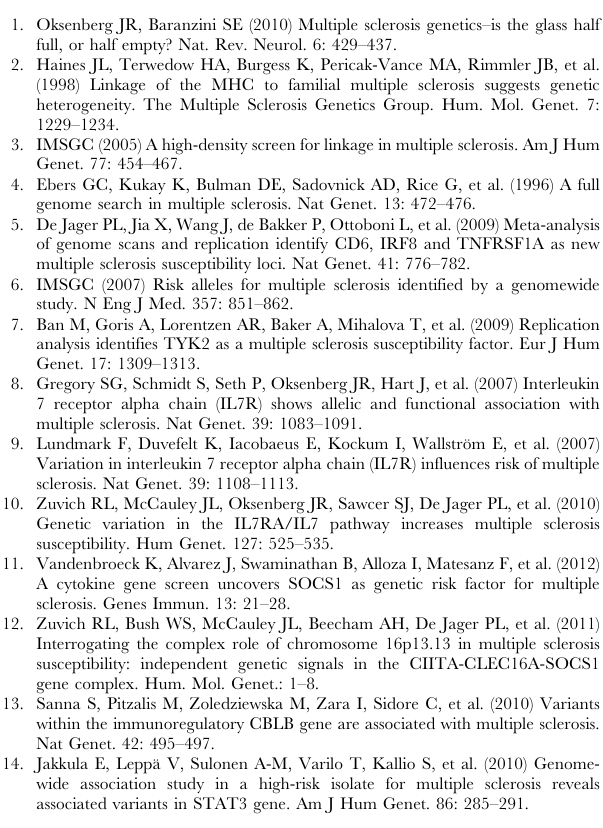
line NKdim cells; T cells, solid line indicates CD4 and dashed line CD8 cells; in the CD4 and CD8 histograms, solid line indicates naive cells (N), dotted line effector memory cells (EM) and dashed line central memory cells (CM). Figure S3 Comparison of CD6 expression on the different cell types with respect to rs11230563 genotypes. Figure S4 Comparison of CD6 expression on the different cell types with respect to rs2074225 genotypes. Figure S5 Comparison of proliferation and cytokine levels (pg/ ml) between the three haplotypes. PBMCs representing each of the haplotypes (CC= protective, CT = high risk, TT = mild risk) from the healthy donors were cultured in a 48-well plate for three different stimulatory conditions – unstimulated, OKT3 stimulated (100 ng/ml) with/out anti-CD6 161.8 (10 m g/ml). Proliferation was assessed by measuring 10 6 cells stained with eFluor670 on the third day of culture. The supernatant collected from the three-day culture was used to quantify IL-17A and IFN- c using ELISA. Each column represents the mean values of the samples. Comparison of proliferation rates and cytokine production was done by the non-parametric Mann-Whitney-U test using Graph- pad software (version 5). Table S1 Demographic and clinical variables of the PBMC samples collected from MS patients for the functional study.